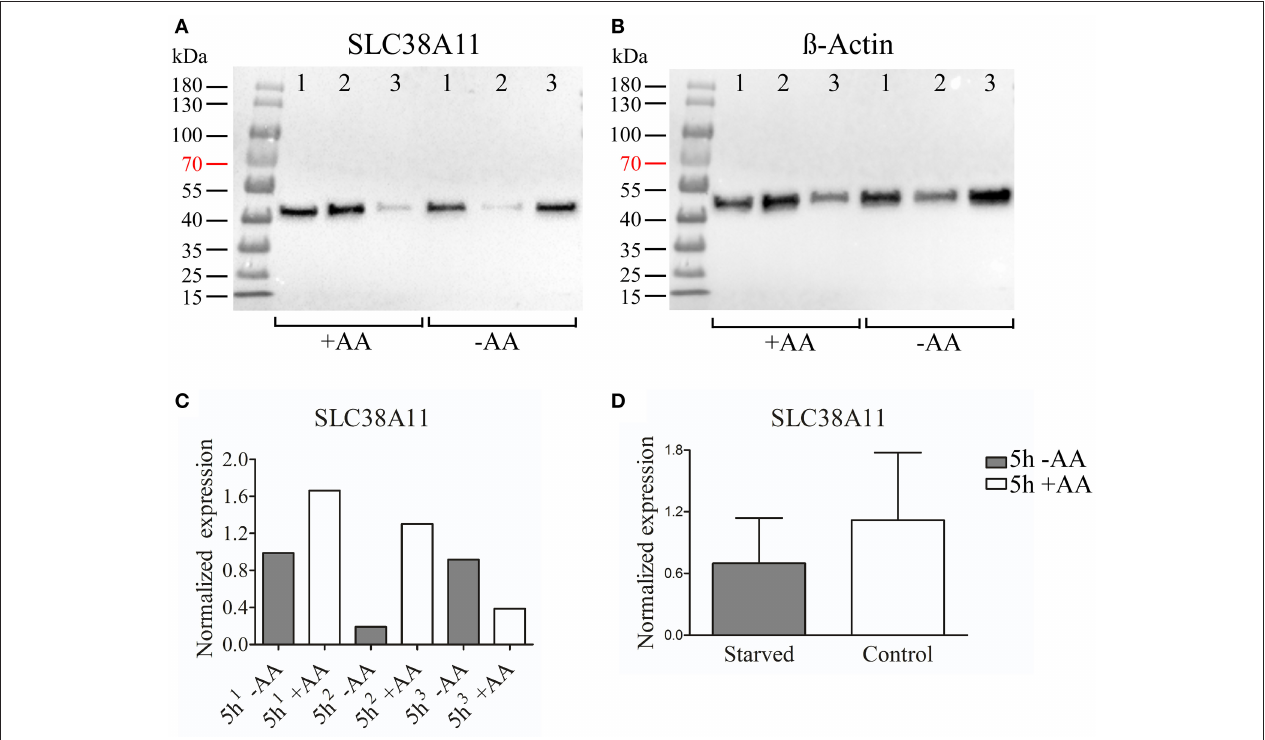
FIGURE 3 | Western blot analysis of SLC38A11 protein expression in the immortalized hypothalamic cell line N25/2 after complete starvation at 5h. (A) The blot (developed for 2.0s) show the protein expression of SLC38A11 in three replicates (1, 2, 3) in each treatment group. The predicted size of the mouse SLC38A11 protein is 49.6 kDA (453 amino acids, NP_796048) and a band with approximate size of 46 kDA was detected. (B) The blot (developed for 2.0s) visualizes the protein expression of β -actin which was used to normalize the protein expression in each sample. (C) The graph displays the normalized protein expression of SLC38A11 in the starved cells compared with the amino acid treated controls for each sample. (D) The graph represents the normalized protein expression of all replicates in each treatment group (mean value of protein expression ± SD). An unpaired t -test was performed between the protein expression in starved cells and controls. No difference ( p = 0.4108) of protein expression for SLC38A11 was